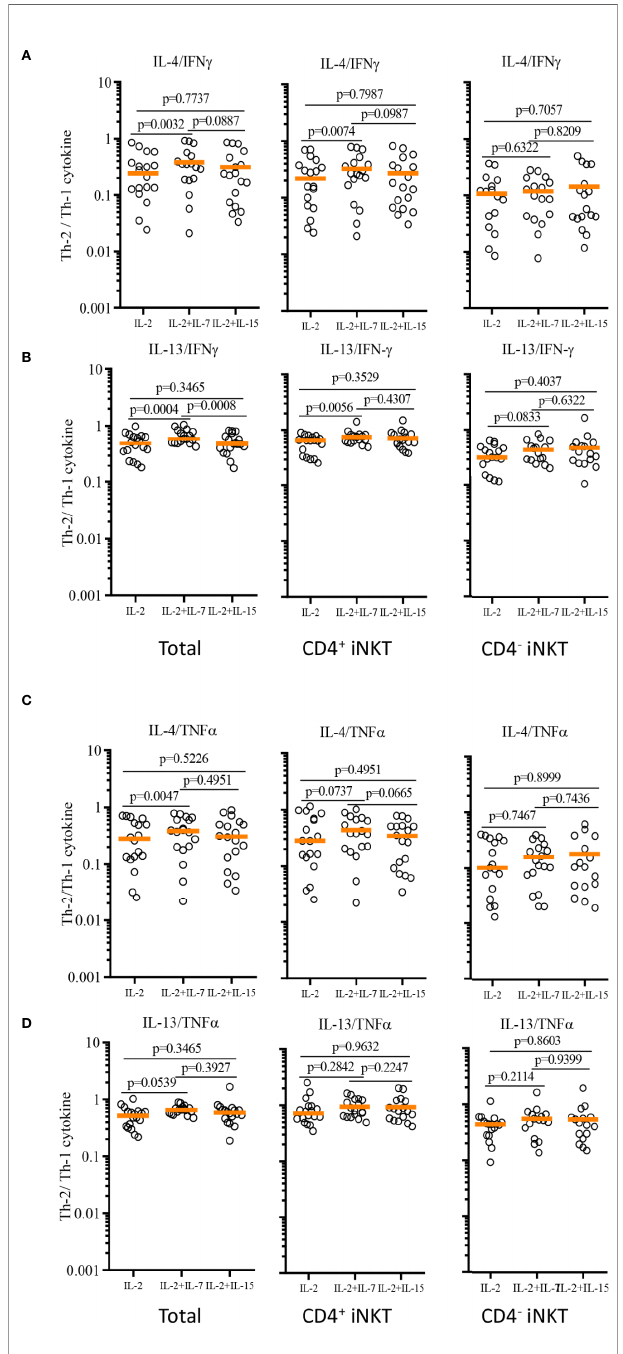
FIGURE 7 | Ratios of Th-2 to Th-1 cytokine production pro fi le of expanded human iNKT cells. Ratios of Th-2 cytokine (IL-4 and IL-13) + iNKT cells to Th-1 cytokine + iNKT cells were calculated for IL-4/IFN g (A) , IL-13/IFN g (B) , IL-4/TNF a (C) , IL-13/TNF a (D) from iNKT cells after antigenic stimulation with IL-2, IL-2+IL-7, and IL-2+IL-15. Horizontal orange lines represent median values; p values are shown in the above each group. Each symbol represents a value from a single